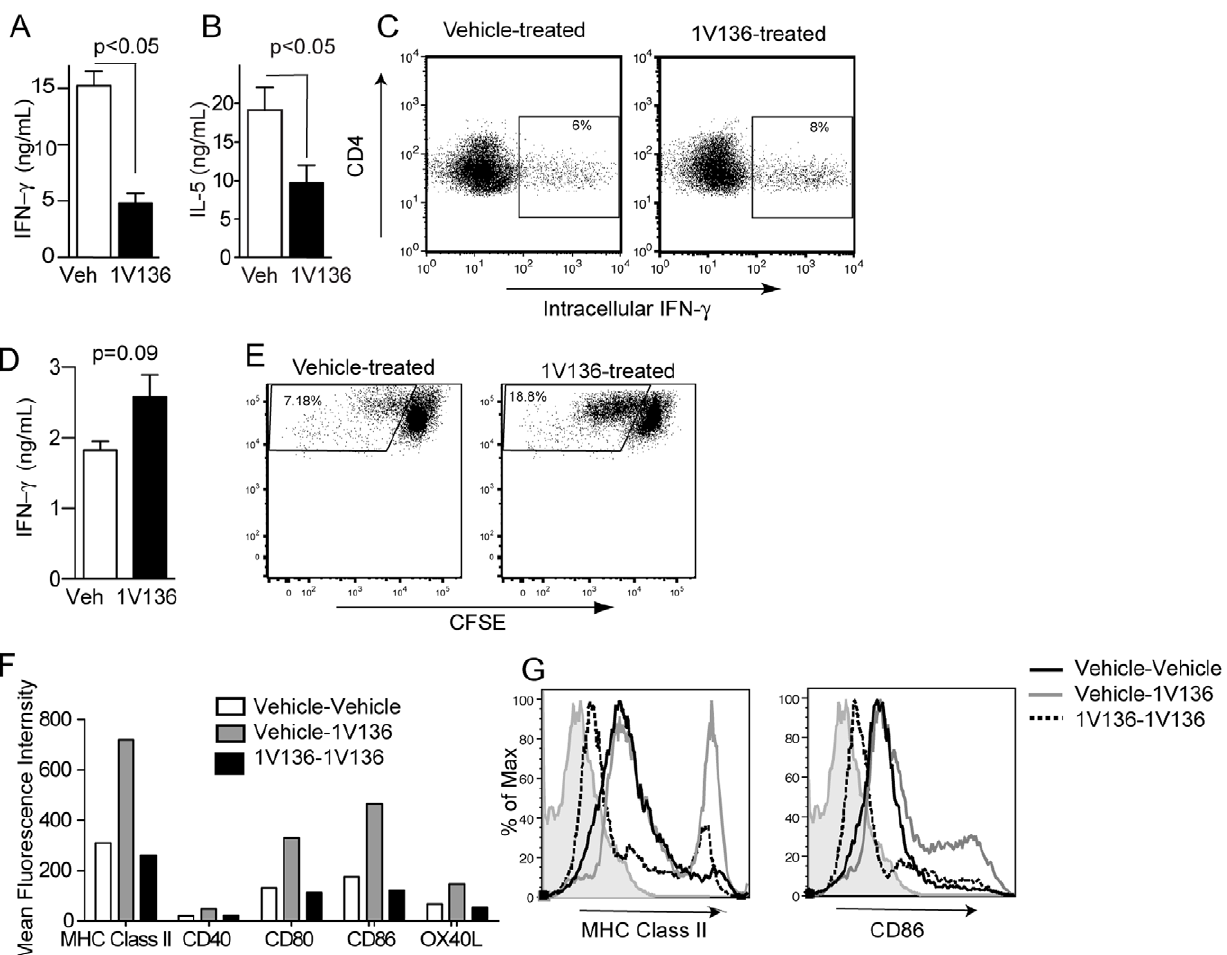
Figure 1. TLR7 ligand treatment reduced antigen specific T cell responses and dendritic cell activation. C57BL/6 mice (n=5/group) were intradermally immunized with OVA (50 m g) mixed with (A) ISS-ODN (50 m g) or (B) alum (0.5 mg) on days 0 and 7. Immunized mice were treated daily with 1V136 (150 nmol/mouse) (black bar) or vehicle (white bar) s.c. from day 7 onward. On day 21 mice were sacrificed and splenocytes were harvested. Splenocytes were cultured with OVA (100 m g/ml) ex vivo for 5 days, and IFN- c (A) or IL-5 (B) in the culture supernatant was measured by ELISA. p , 0.05 by Student t test compared to vehicle treated. (C) On the day of harvest the splenocytes were also nonspecifically stimulated with PMA and ionomycin, and CD4 + T cells were analyzed by flow cytometry for intracellular IFN- c . Data shown are representative of three independent experiments that exhibited similar results. (D) C57BL/6 mice (n=5/group) were intradermally immunized with OVA (50 m g) mixed with ISS-ODN (50 m g) on days 0 and 7. Immunized mice were treated daily with 1V136 (150 nmol/mouse) (black bar) or vehicle (white bar) s.c. from day 5